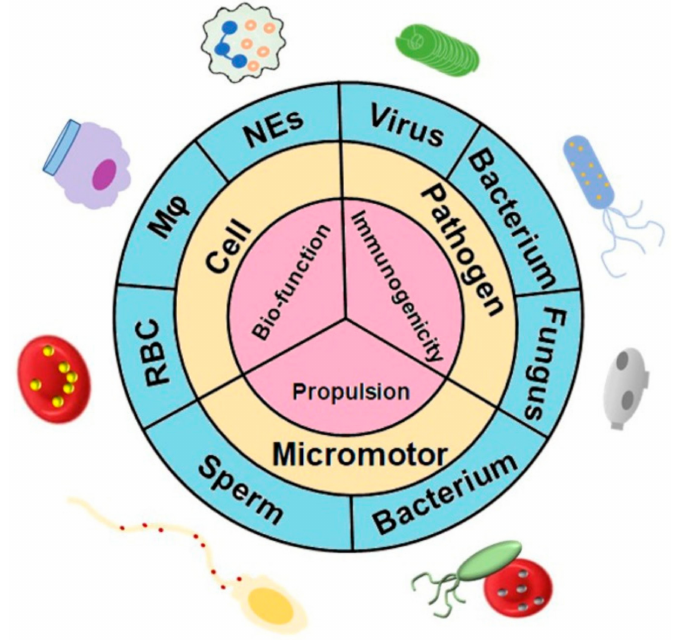
Figure 1. Bioinspired and biomimetic nanomedicines for targeted drug delivery. A variety of natural living systems have been used as sources of carriers for targeted delivery of therapeutic agents. These biohybrid drug delivery systems not only preserve the physicochemical properties of the synthetic materials but also provide unique biofunctionalities supplied by integrated cells. The strategies of targeted delivery systems can be adapted according to the desired applications. Abbreviations: M ϕ , macrophage; NEs, neutrophils; RBC, red blood